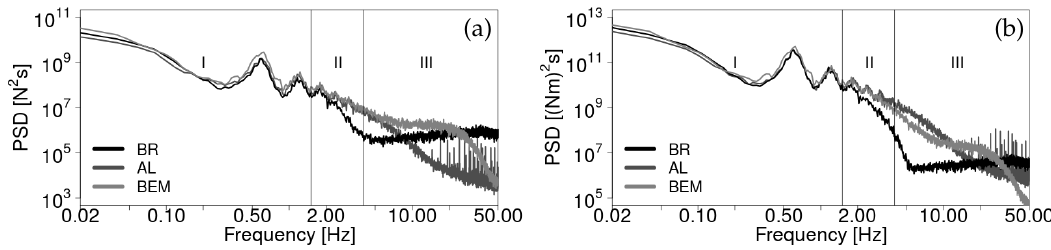
Figure 16. PSD of ( a ) thrust and ( b )